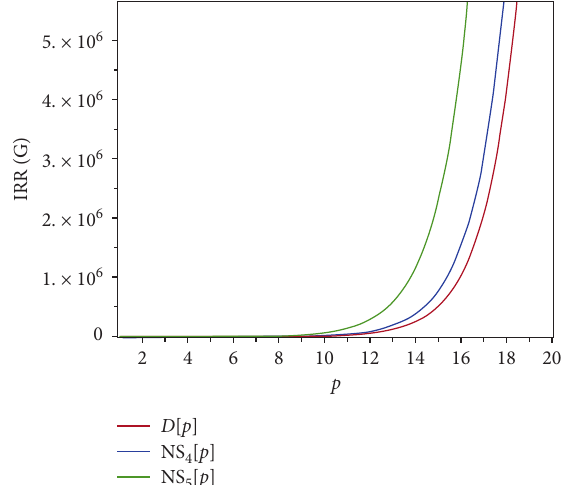
Figure 6: Curves of irregularity index